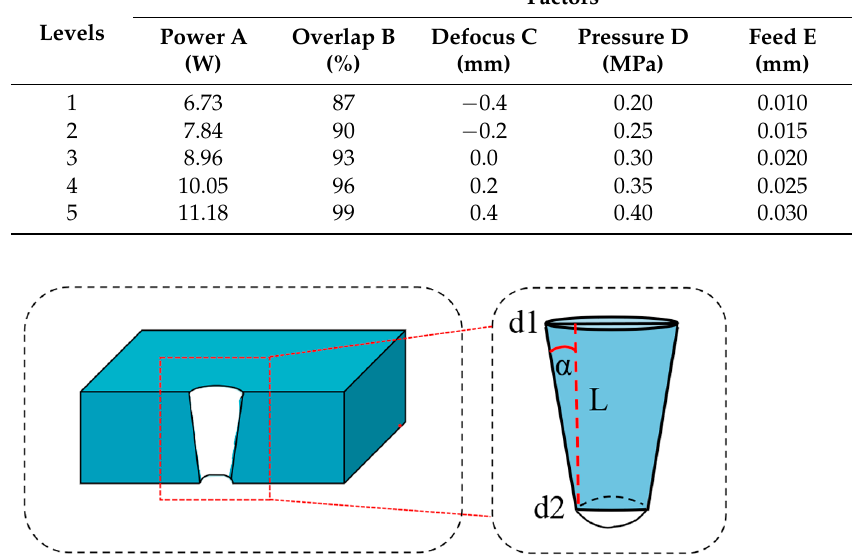
Figure 4. Schematic diagram of taper calculation. Table 2. Factors and levels.